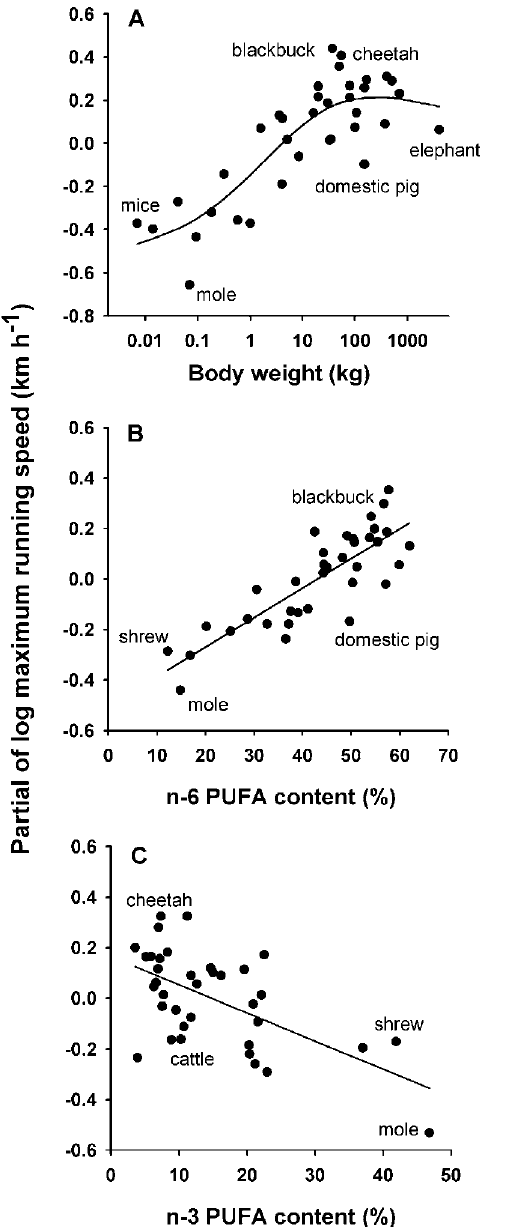
Figure 1. Maximum running speed in mammals. (A) MRS as a function of body weight. (B) The relation of MRS to n-6 PUFA content, and to (C) n-3 PUFA content in phospholipids of skeletal muscles. Shown are partial residual plots (i.e. the independent effect of each predictor variable) from general additive mixed models using a smooth term for body weight (estimated df=2.66, F=4.77, P= , 0.001) and linear terms for n-6 and n-3 PUFA content. To adjust for phylogenetically caused correlations models included the family membership of each species as a random factor.